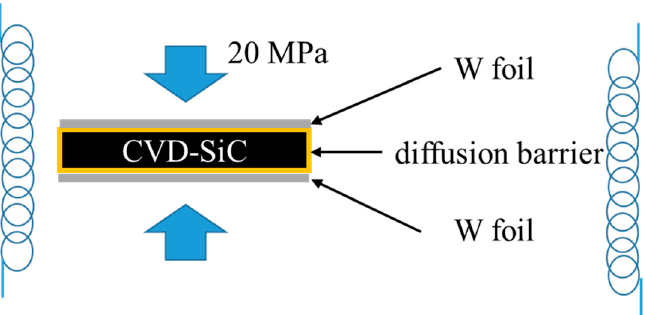
Figure 1. Schematic diagram of W joined with diffusion barrier coated CVD-SiC.